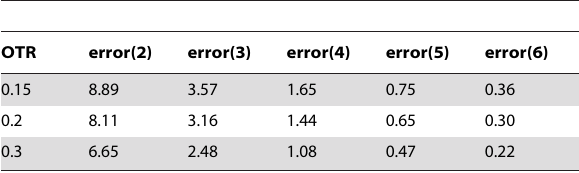
Table 5. Relative errors in percentage for the effective resistance of F-trees.